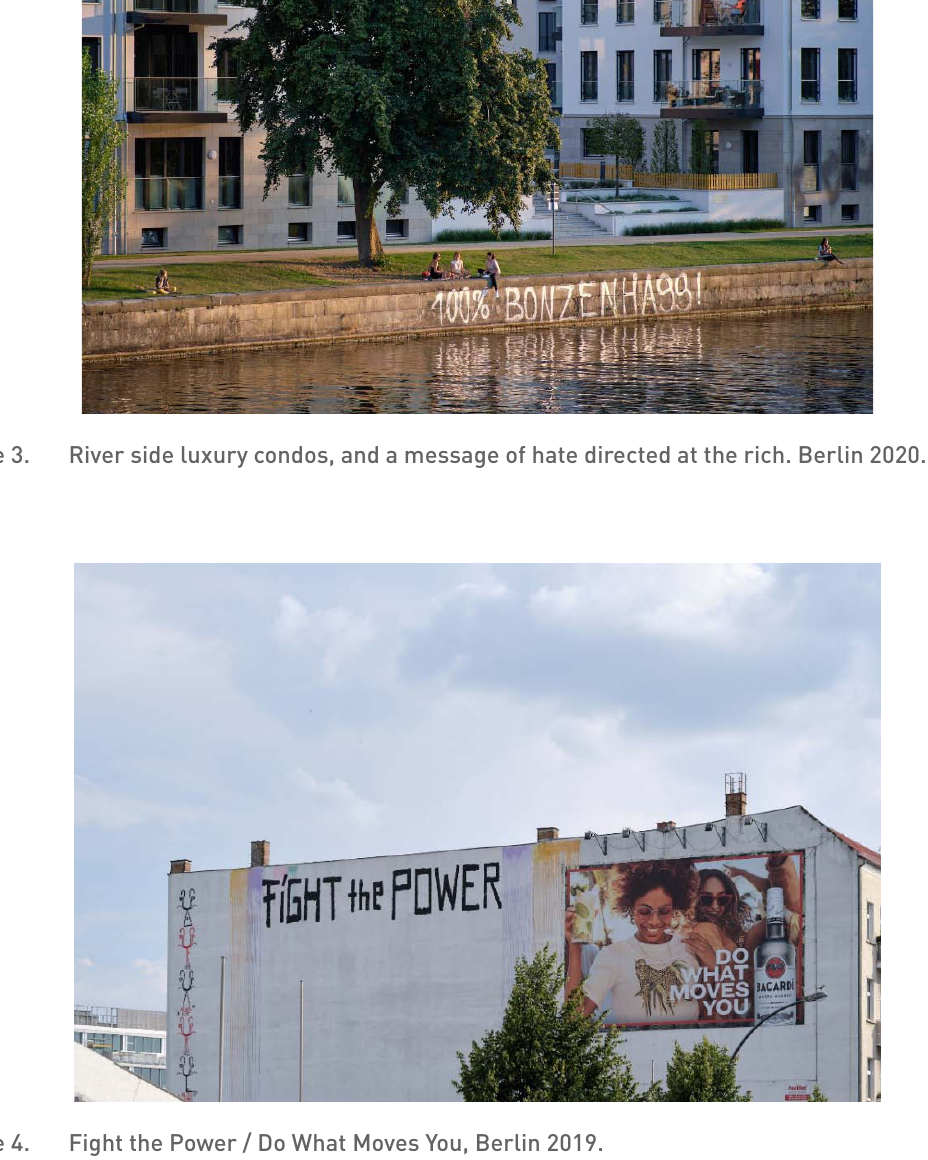
Figure 4. Fight the Power / D o What Moves You, Berlin